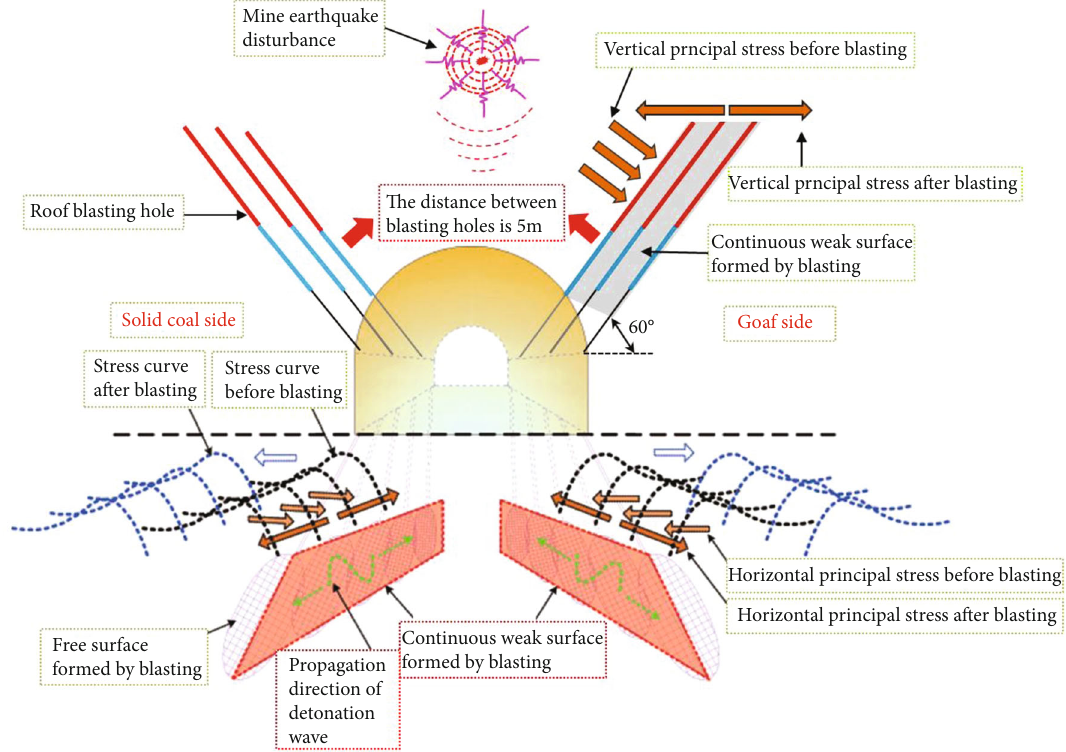
Figure 11: Blasting blocking stress